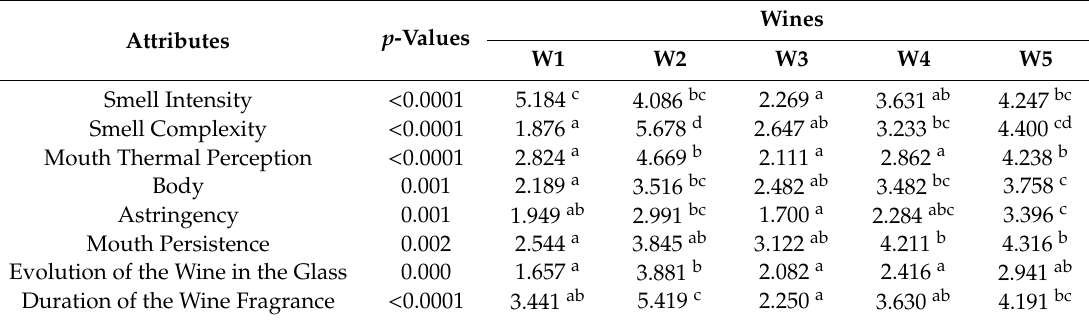
Table 3. Mean scores for each attribute in the